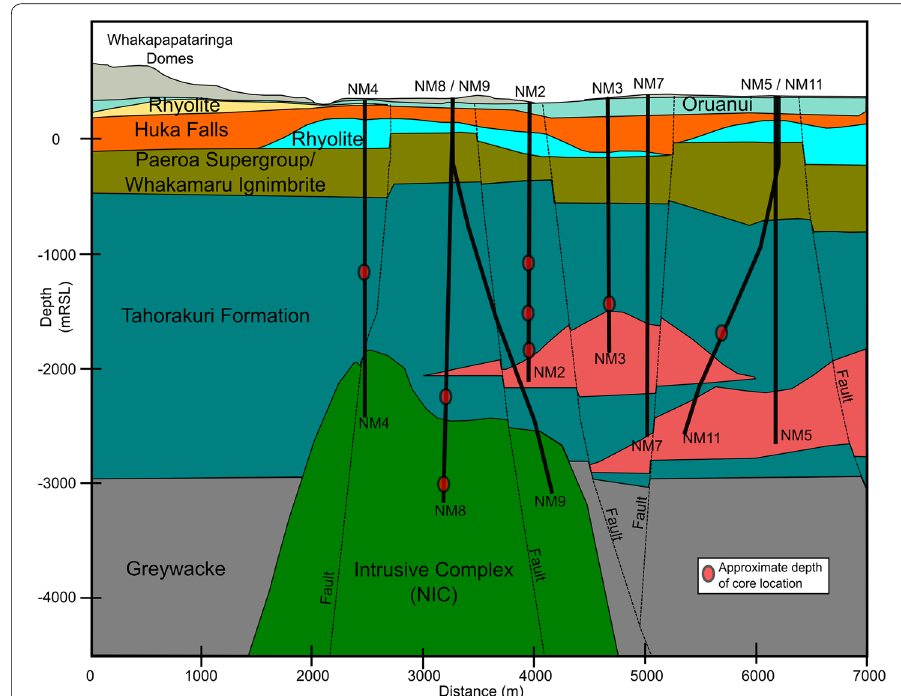
Fig. 2 Geological cross section of the Ngatamariki geothermal field from the NW to the SE with boreholes NM1–NM11 projected (after Bignall 2009; Boseley et al. 2012; Chambefort et al. 2014 and Mercury NZ Limited internal